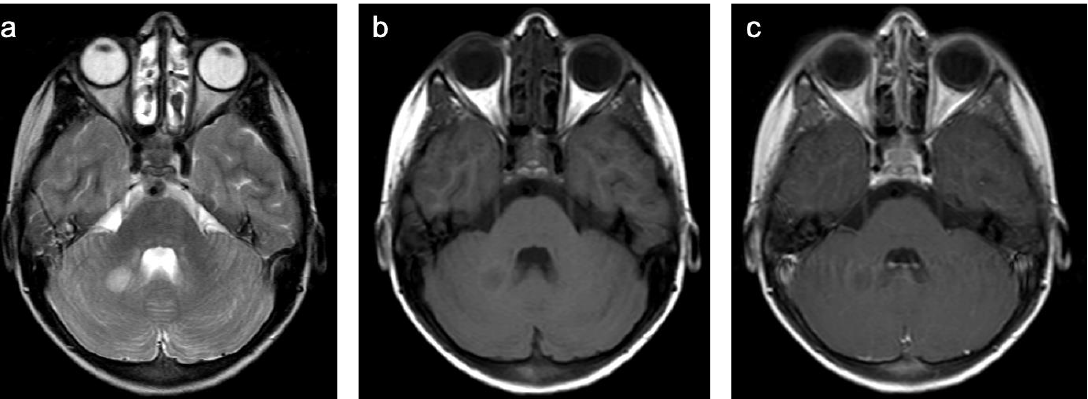
Figure 10. Representative case “White matter damage caused by tumor infiltration”: pediatric type diffuse low-grade glioma. T2W ( a ), T1W pre- ( b ) and post-contrast ( c ) sequences. Ten-year-old girl diagnosed with a pediatric type diffuse low-grade glioma. T2W sequence shows mass-like hyperintense lesion, predominantly located in the white matter of the right cerebellar hemisphere ( a ). No contrast enhancement present ( c ).